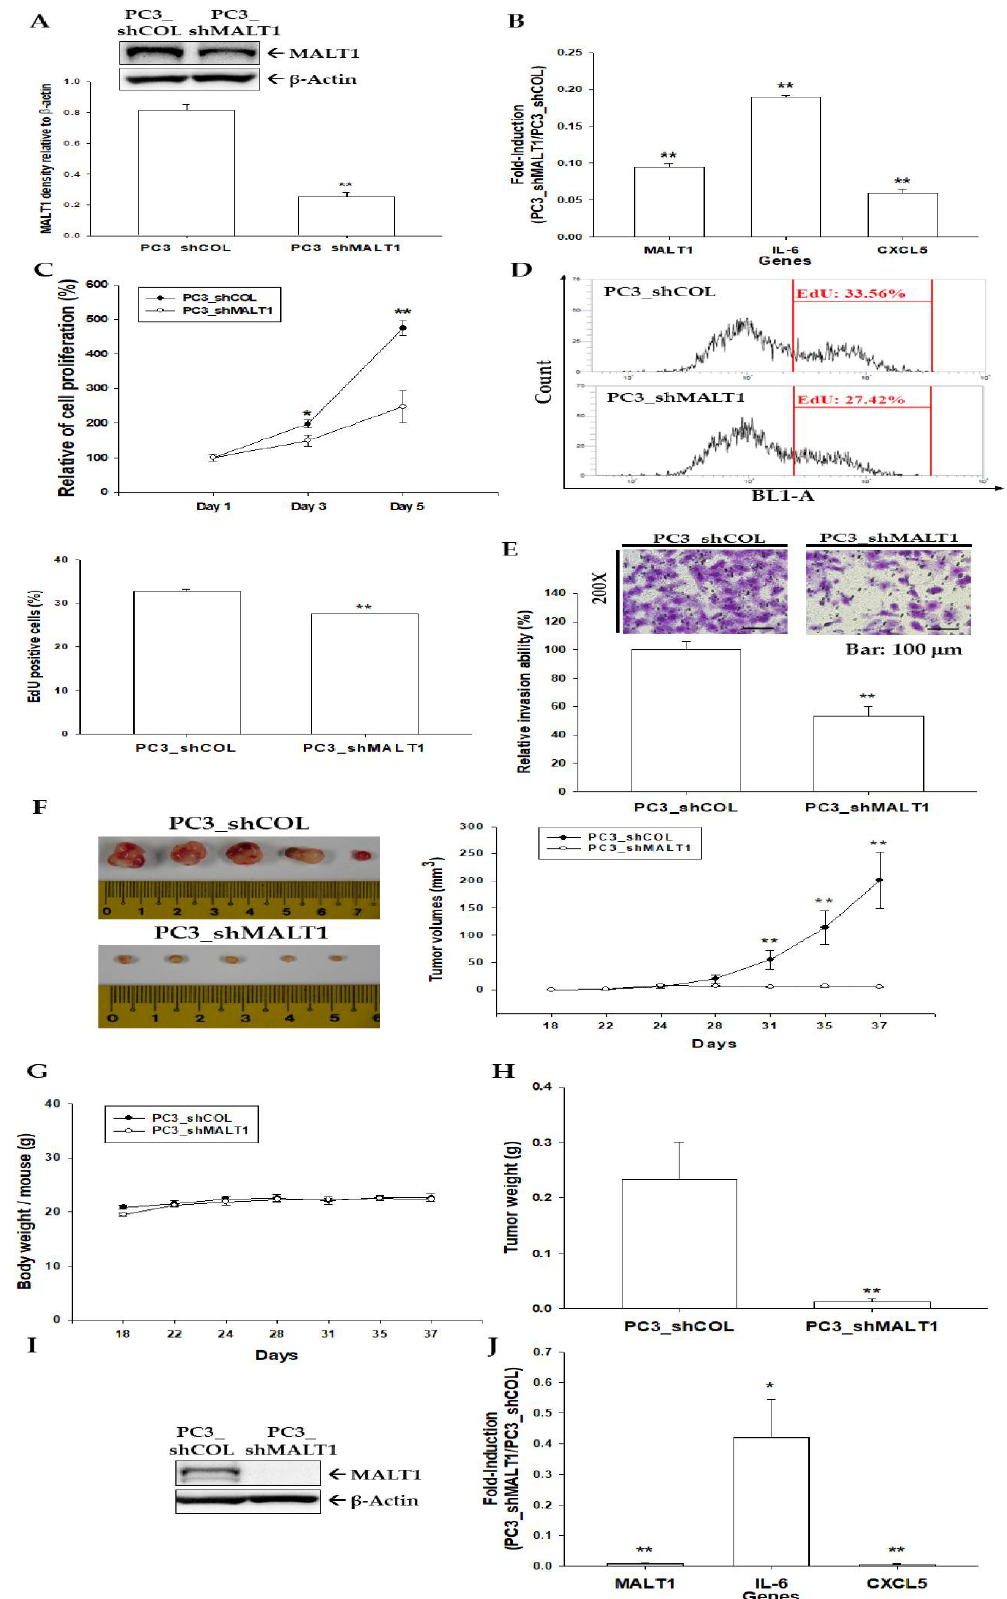
Figure 4. Effect of MALT1 knockdown on cell proliferation, invasion, and tumor growth in PC-3 cells in vitro and in vivo. ( A ) Relative expression of MALT1 in MALT1 knockdown PC-3 cells was assessed by immunoblot assays (top) and the